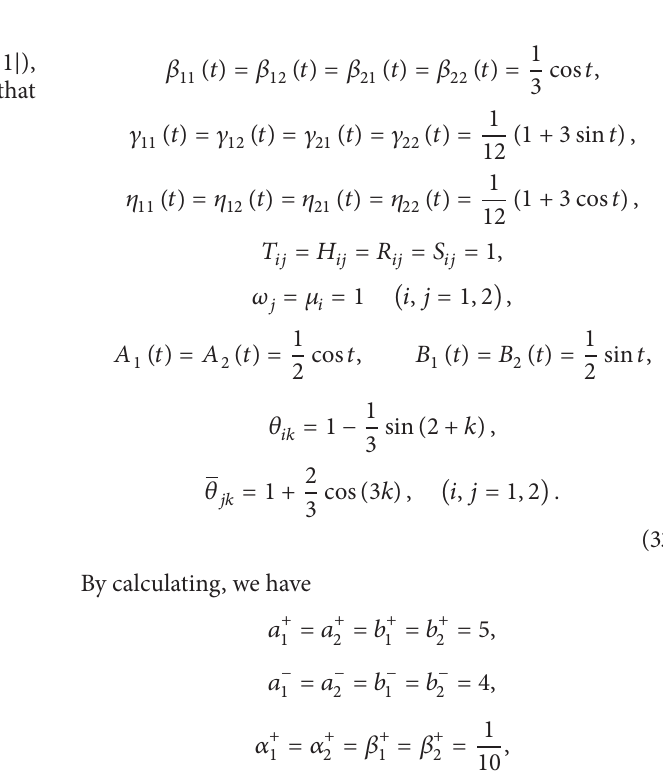
Figure 1: Phase responses of states 𝑥 1 , 𝑥 2 , 𝑦 1 , and 𝑦 2